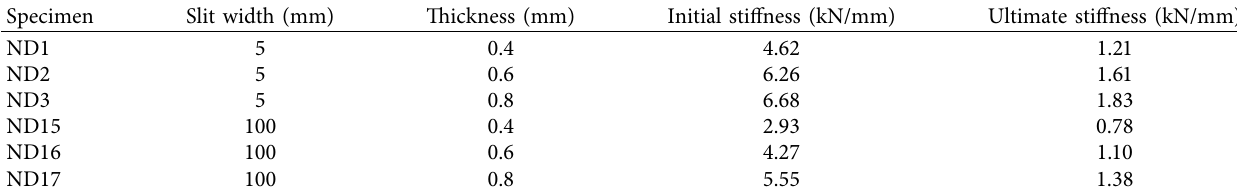
Figure 20: Stiffness curves of slit width 100mm. Table 8: Stiffness of different